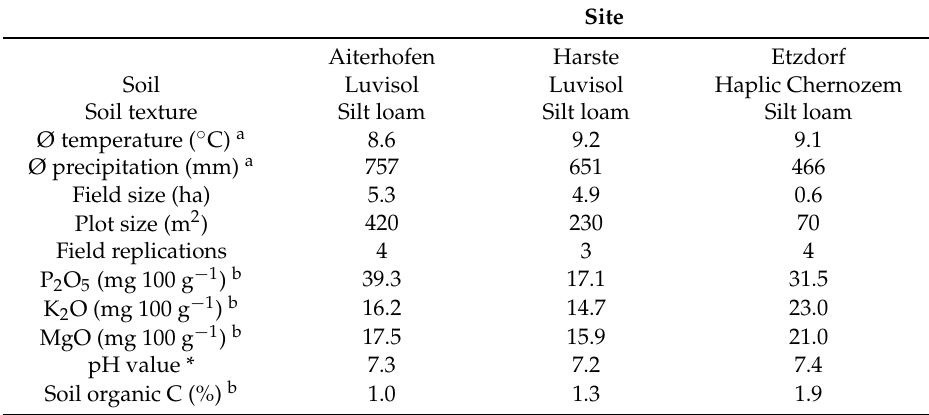
Table 3. Site characteristics of the three crop rotation trials in Germany (2011–2013).